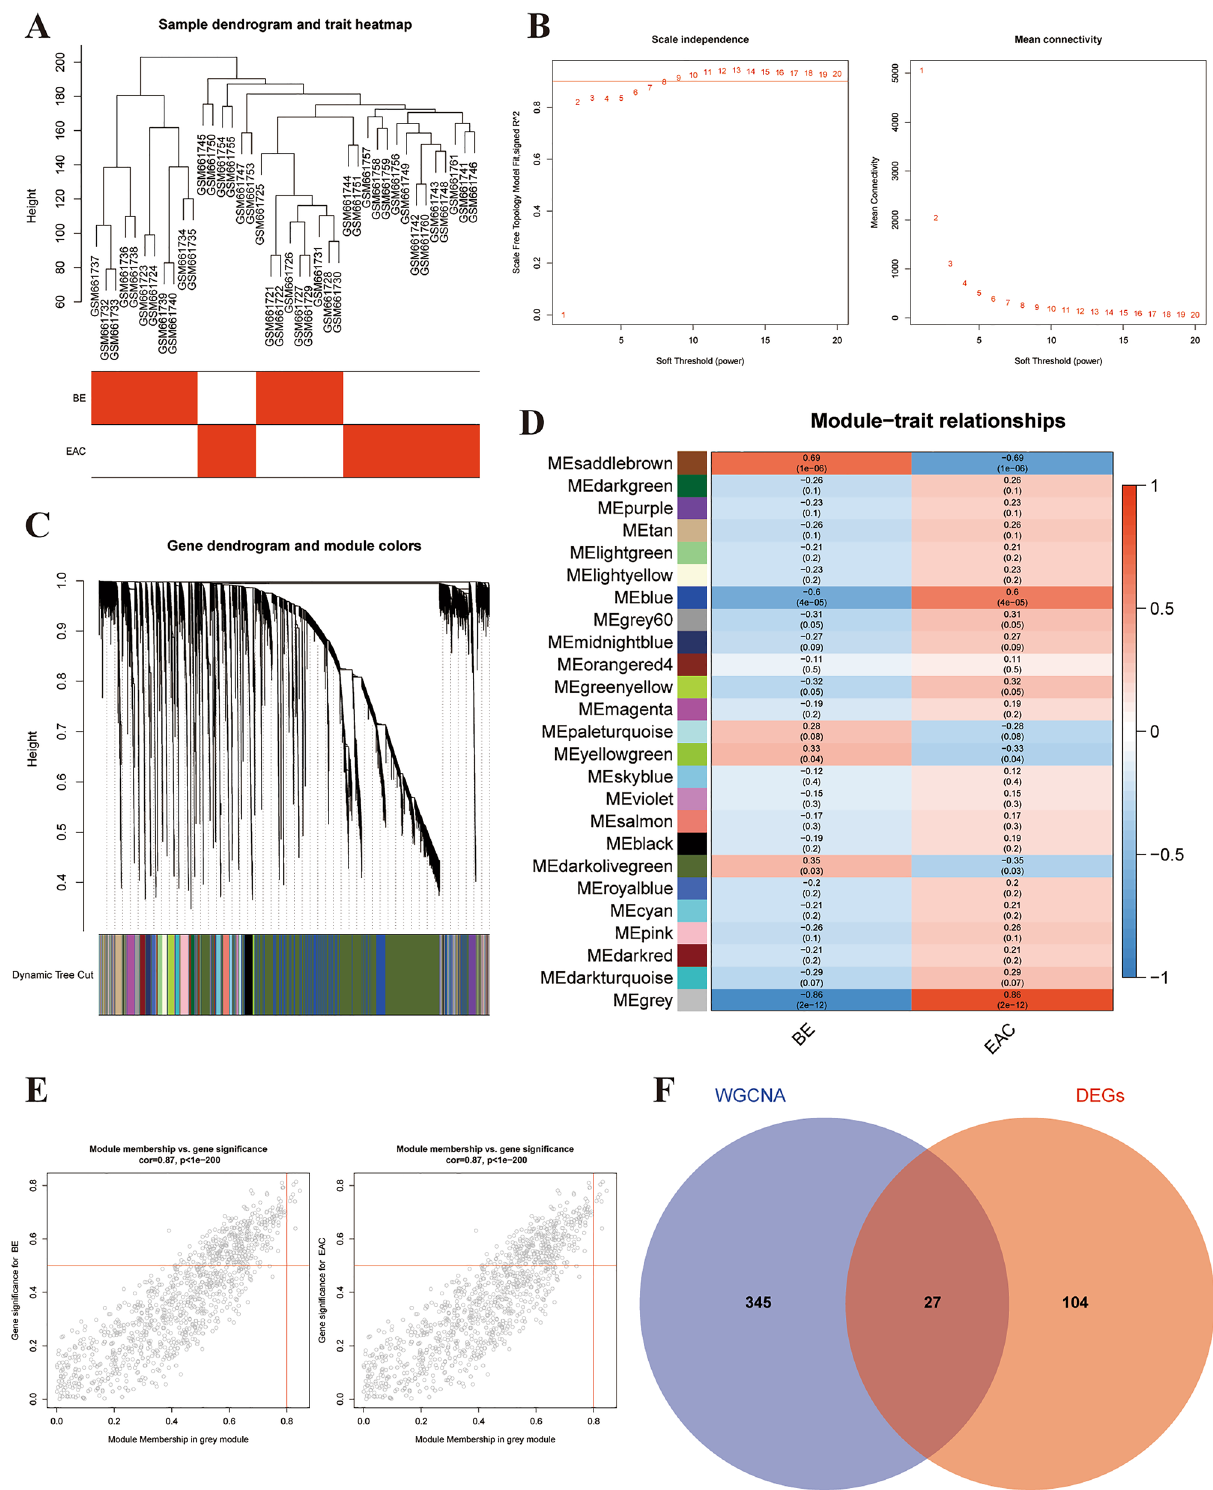
Figure 3. WGCNA to identify trait-related modules and genes. ( A ) Sample dendrogram and trait heat map; ( B ) calculating soft-thresholding power; Left: scale-free fit indices using different soft-thresholding powers; Right: mean connectivity using different soft-thresholding powers; ( C ) the dendrogram clustered by Dynamic Tree Cut algorithm; ( D ) the heatmap profiling the correlations between module eigengenes and the clinical characteristics; ( E ) scatter plot of gene significance in grey module; Left: BE; Right: EAC; ( F ) Venn diagrams displayed the overlapping genes between trait-related genes in grey module and